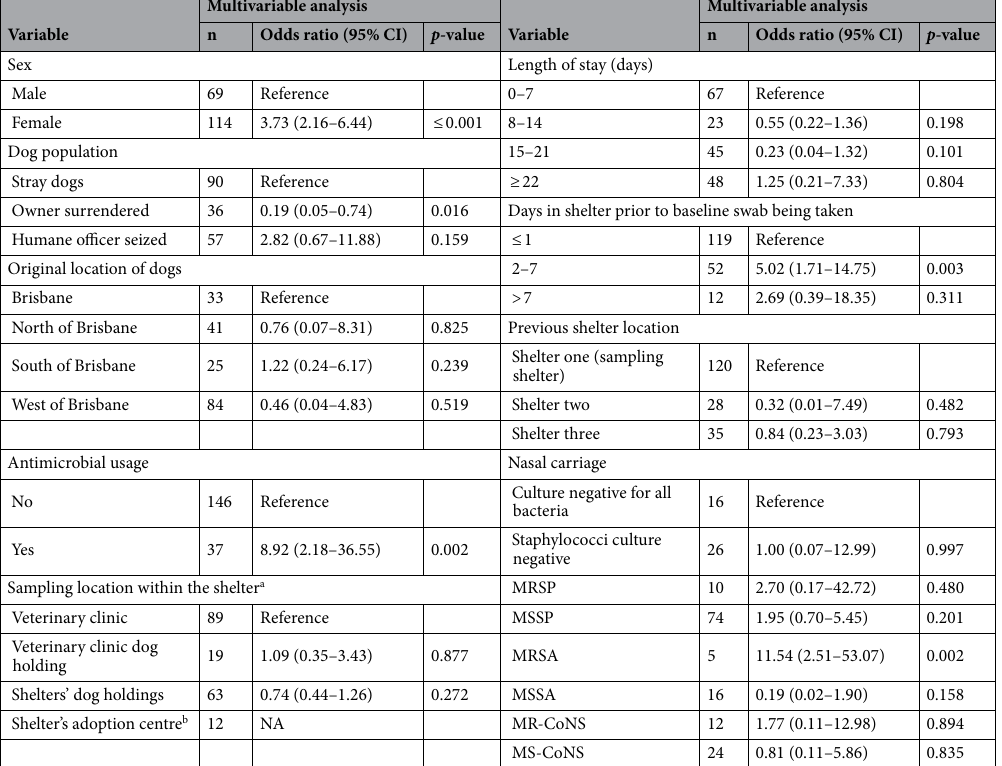
Table 1. Multivariable analysis of the risk factors associated with shelter dogs with dermatological conditions. For all variables in the multivariable model, there were 183 nasal samples included. n the number of individual samples per variable. MRSP methicillin-resistant S . pseudintermedius , MSSP methicillin- sensitive S . pseudintermedius , MRSA methicillin-resistant S . aureus , MSSA methicillin-sensitive S . aureus , MR-CoNS methicillin-resistant coagulase-negative staphylococci, MS-CoNS methicillin-sensitive coagulase- negative staphylococci. a The shelter includes a veterinary clinic, a veterinary clinic dog holding for dogs still requiring veterinary care, dog holdings, and an adoption centre. b The shelters’ adoption centre was omitted from the multivariable model as it predicts failure perfectly (no dogs with dermatological conditions located at the adoption centre). N the number of total samples per variable, n the number of individual samples per variable, NA not